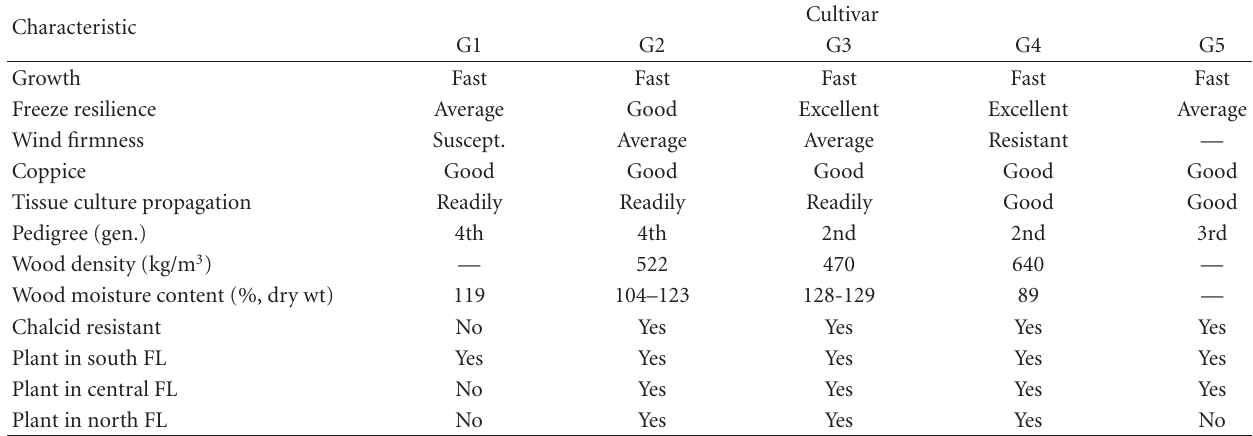
Figure 3: 13.3-year-old G4 on dredge spoils (a) and 2-year-old G1, G2, G3 on phosphate mined land (b) in central Florida. Table 3: Characteristics of E. nergy series E. grandis cultivars G1, G2, G3, G4, and